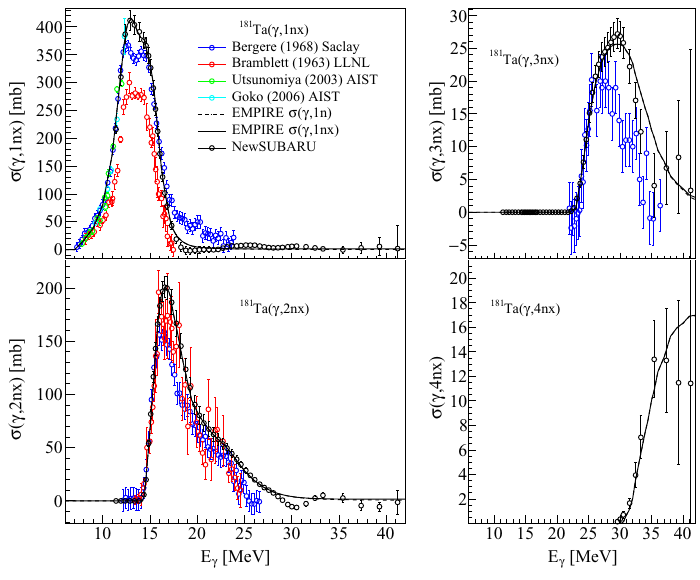
Figure 8. (Color online) The present partial photoneutron cross sections, σ ( γ, in ) with i = 1-4, for 181 Ta compared with the Livermore [24] and Saclay [23] data. The low-energy data [25, 26] are also